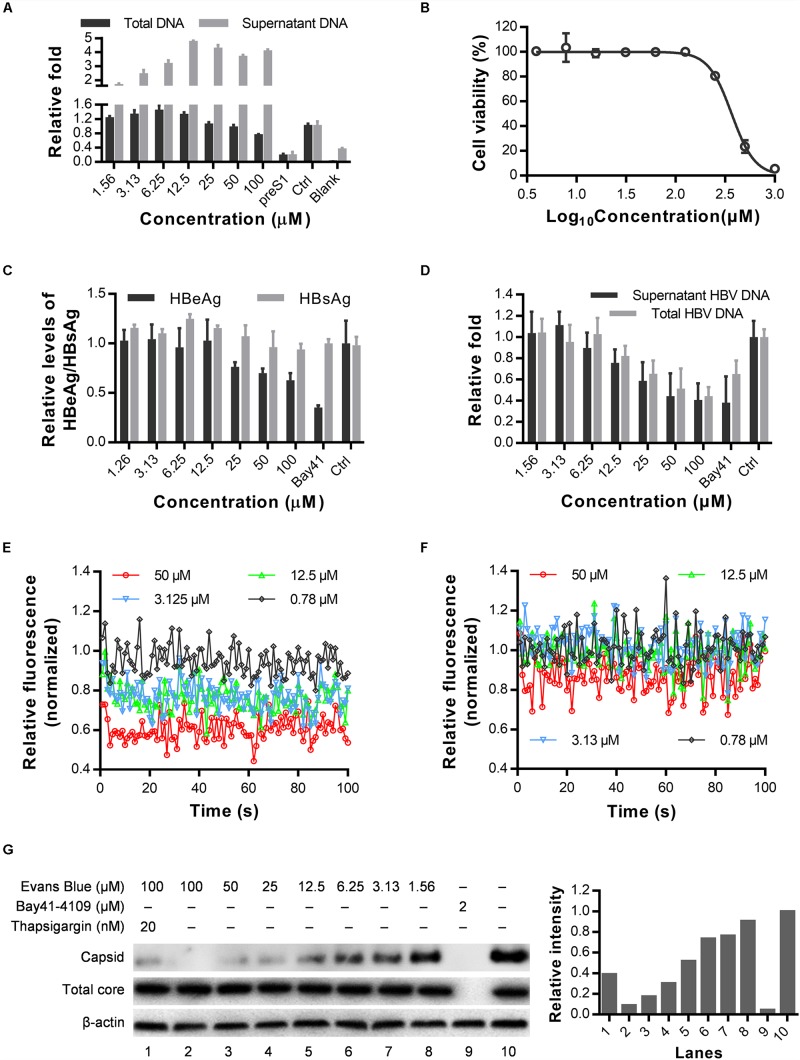
Cytosolic calcium outward induced by Evans blue is required for HBV capsid assembly. (A) HuhDhNTCP was treated with compounds after infection for 6 days, supernatant HBV and total HBV DNAs were detected by real-time PCR. (B–D) Drug toxicity and antiviral effects of long-term (6 days) treatment of Evans blue on HepAD38 cell line. The antiviral effects of Evans blue treatment were determined by HBeAg, HBsAg, total DNA, and supernatant HBVs. (E,F) Cytosolic calcium levels in HepAD38 cells treated with Evans blue alone (E) or with Evans blue and 10 μM thapsigargin (F) were determined using a calcium dye. (G) HepAD38 cells plated in 6-well plates were treated with different concentration of Evans blue for 6 days, and the HBV core protein levels were detected by Western blot, β-actin was used as an internal reference. A particle gel assay followed by western blot was conducted to measure the capsid levels.